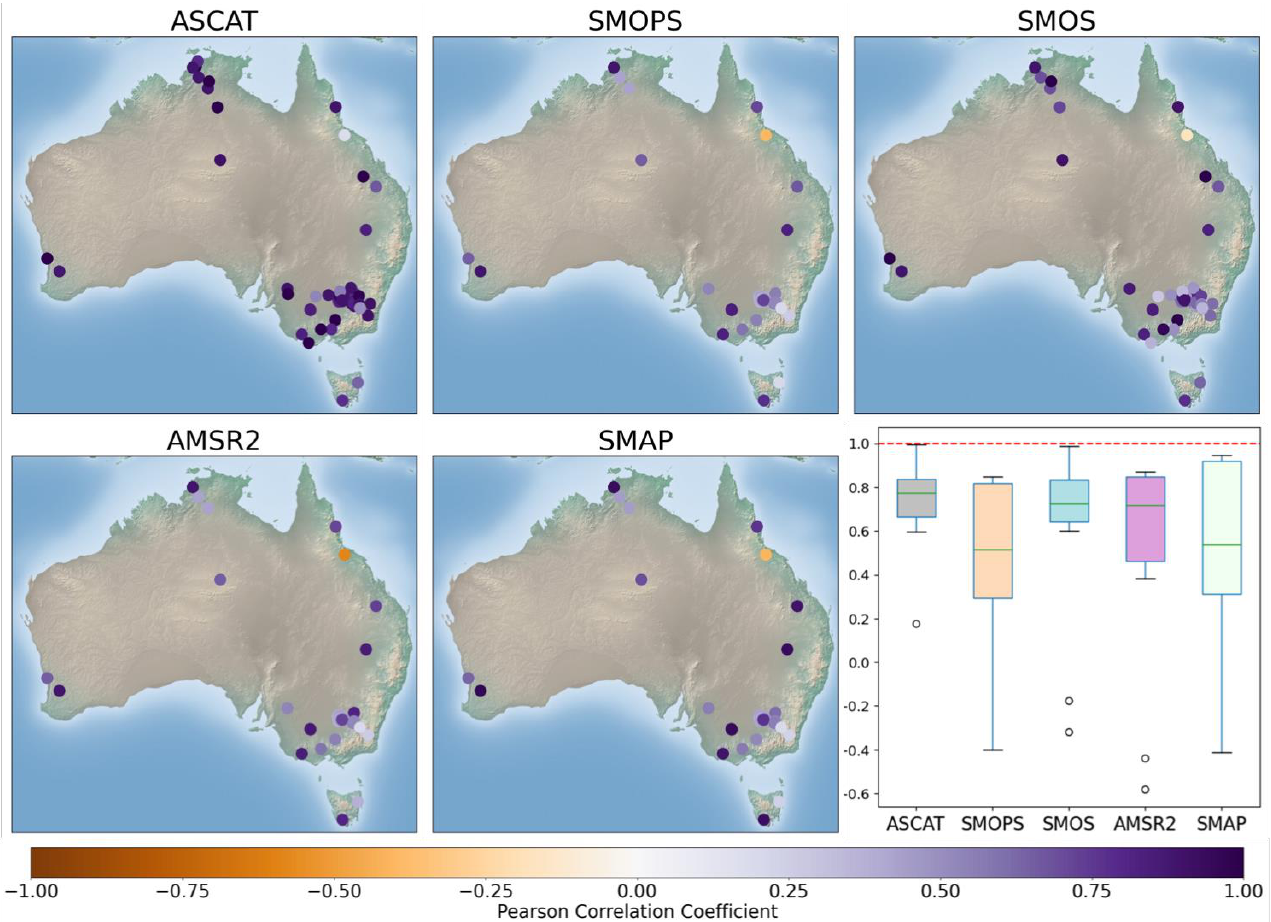
Figure 4. Temporal correlation performance for ASCAT, SMOPS, SMOS, AMSR-2, and SMAP depicted spatially where only stations with a significant correlation are depicted. An accompanying box-whisker plot depicts the spatio-temporal results with outliers that fall outside the interquartile range depicted as black circles, red dashed line indicates perfect value.